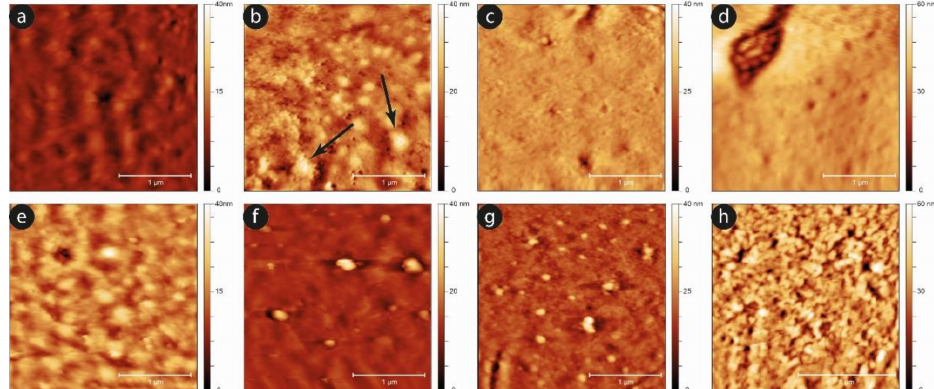
Figure 8. Typical high resolution images of the plasma membrane for static controls (upper panels) and mechanically stimulated samples (lower panels) after one ( a , e ), three ( b , f ), six ( c , g ), and nine days ( d , h ) of aging. The data suggest that the occurrence of features such as micro-vesicles and other membrane markers of aging arises sooner in the mechanically-stimulated